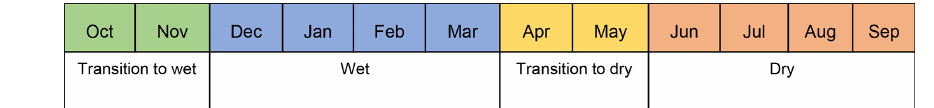
Figure 3. Vernal pool annual moisture cycle.